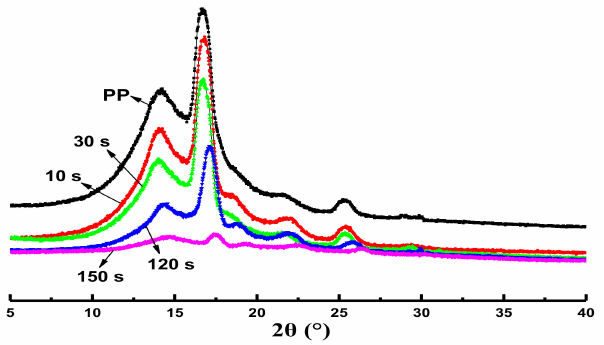
Figure 5. XRD pattern of IIR/PP-TPV samples with different DV